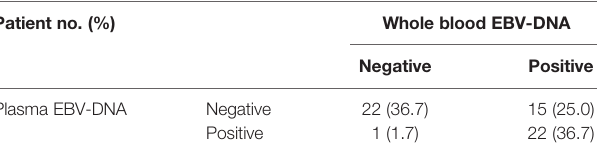
TABLE 2 | Epstein-Barr virus (EBV)-DNA status in the whole blood and plasma at diagnosis. Patient no. (%)